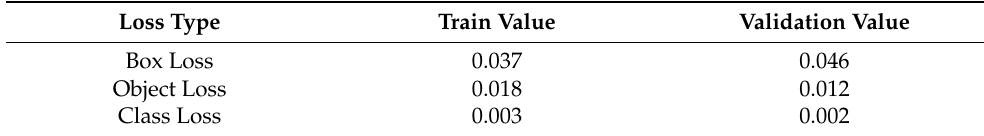
Table 4. Losses of the defined model.